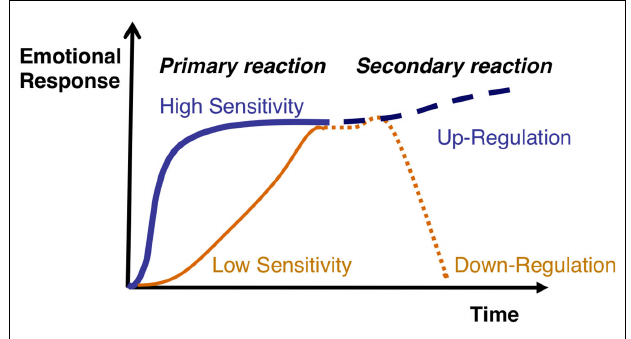
FIGURE 5 | Model of emotional sensitivity versus emotional regulation: taken from Koole (2009). The emotional episode may be viewed as a neural-dynamic representation (our argument) where the primary reaction serves as the prediction of the emotion state and may become stabilized depending on the strength of the prediction. Stabilization would thus occur following some parameterized suprathreshold activation and at such a point activation may impact on behavioral and cognitive systems over an emotion episode.Weaker predictions may not be stabilized. In either case, feedback from the secondary reaction may lead to down- or up-regulation (self-amplification, also see Lewis, 2005). Reprinted with